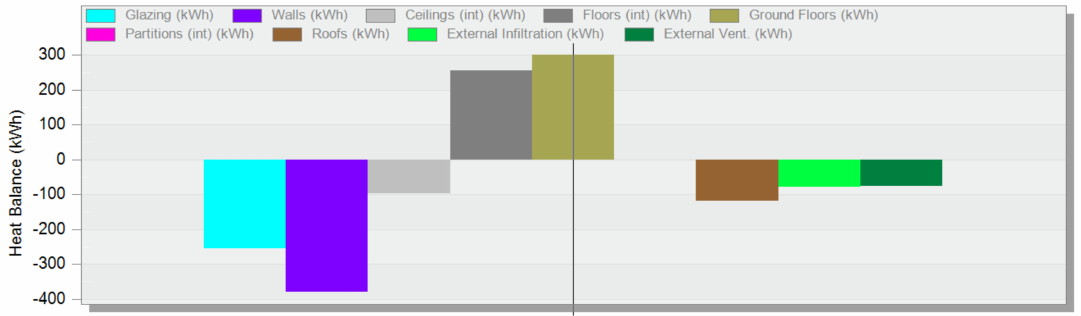
Figure 11. Energy balance of the building in March.